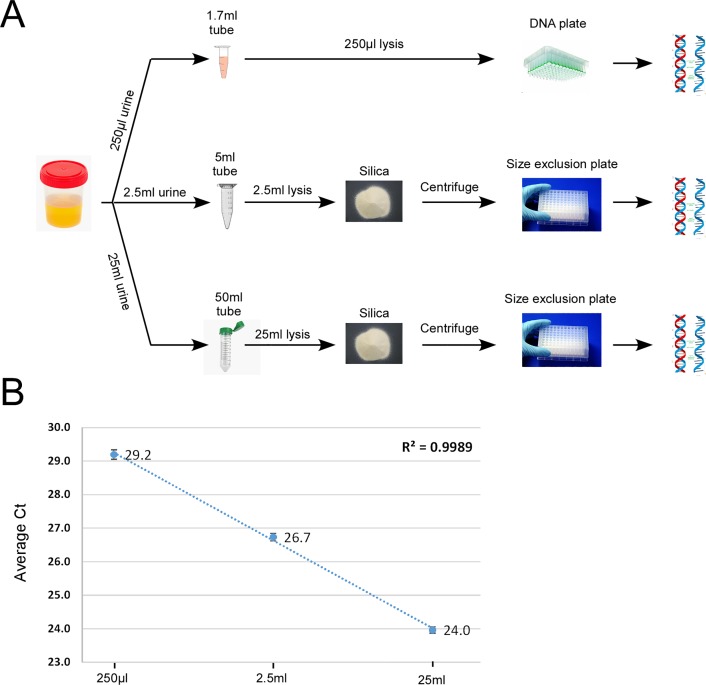
Adapting the current protocol for use with larger urine volumes.A) Schematic showing parallel extraction methods for use with 2.5ml and 25ml of urine. A more detailed schematic is presented in S5 Appendix and detailed protocols in S2–S4 Appendices. B) Use of larger volumes leads to a linear improvement in nucleic acid recovery as assessed by qRTPCR cycle threshold (Ct) values for human actin.